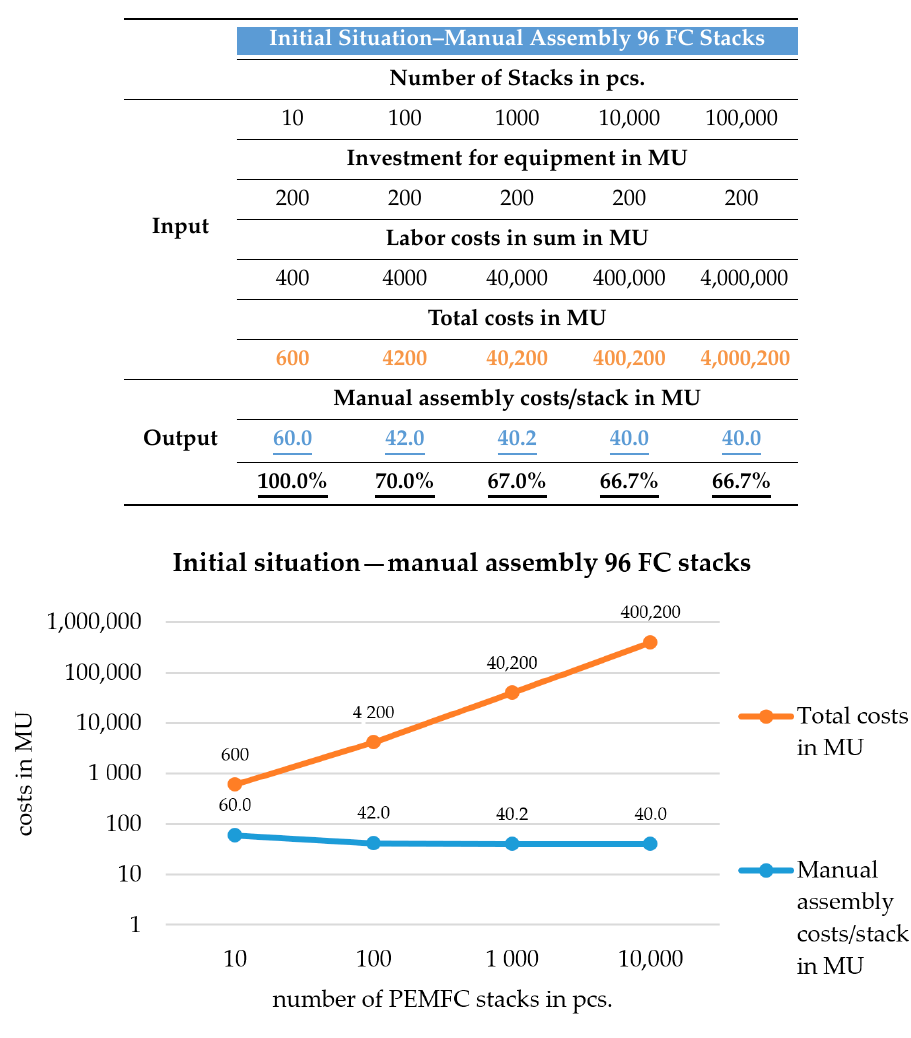
Figure 11. Baseline—manual assembly—production time 40 h/stack with 1 operator.